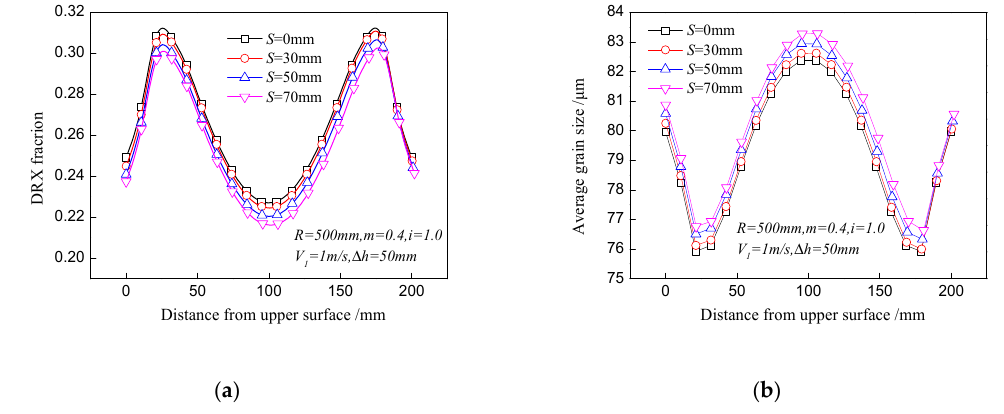
Figure 6. Effect of offset distance on distributions of ( a ) DRX fraction and ( b ) average grain size in asymmetrical shear rolling.